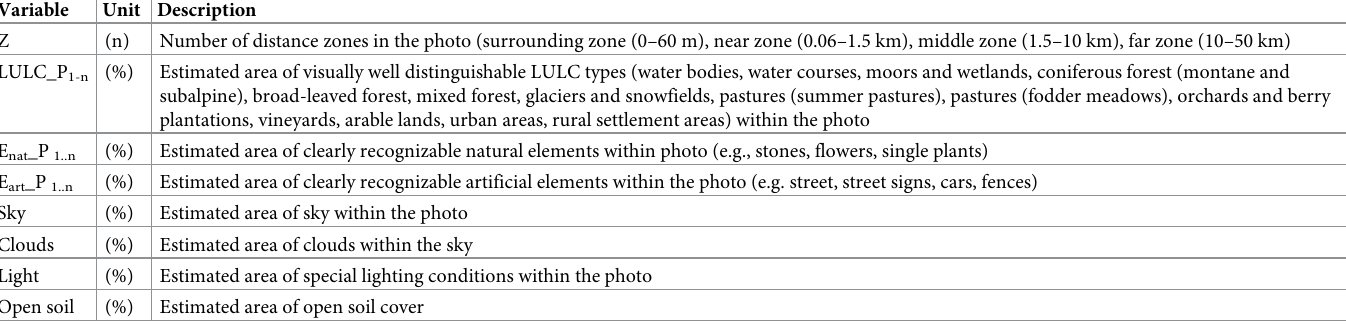
Table 2. Variables extracted from visual photo content analyses.